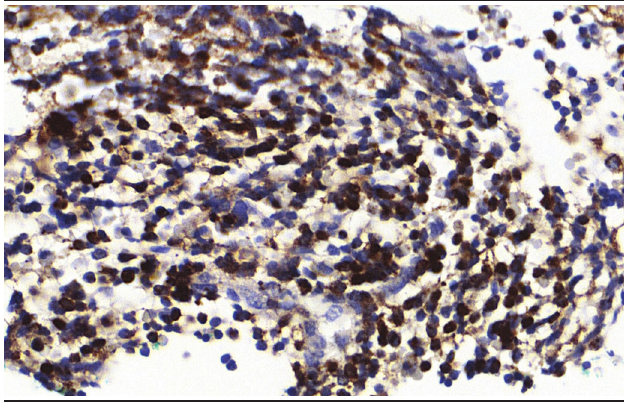
figurE 5 − Bone marrow biopsy, immunohistochemistry (TdT, 400×) Nuclear positivity for TdT indicates the diagnosis of ALL. ALL: acute lymphoblastic leukemia.